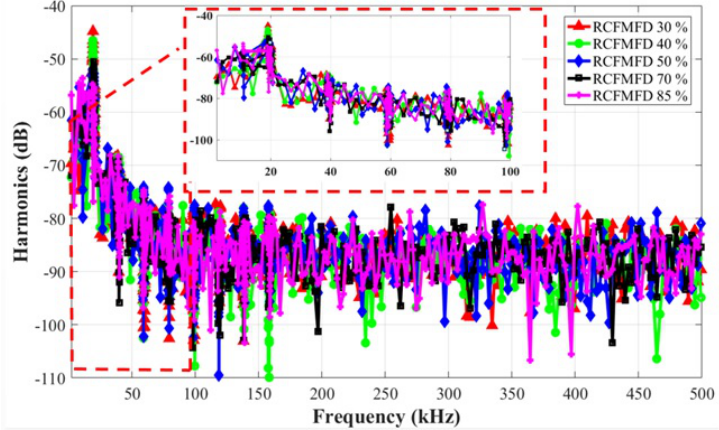
Figure 15. Comparison of the switching current harmonics results for various randomness levels of RCFMFD for a simple buck